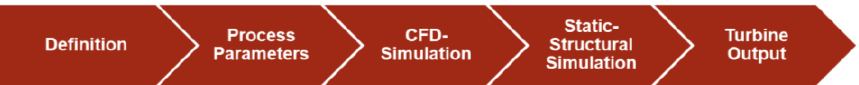
Figure 9. Process flow definition for the execution of the project.